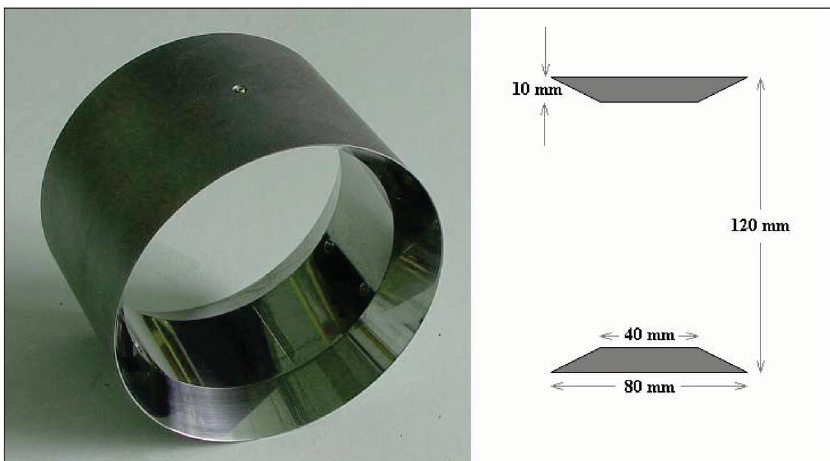
FIG. 1. (Color) Photograph and cross-sectional view of one of the antigrazing rings. At the top of the photograph one of five set screws are visible that are used for positioning and fastening the rings in the beam pipe. The tapering of the ridge edges is introduced to further reduce their already very small impact on ring impedance [4]. A slight taper (not shown) of the inner, 40 mm wide, surface provides a 6 mrad angle with respect to the beam axis to minimize any grazing collisions with this